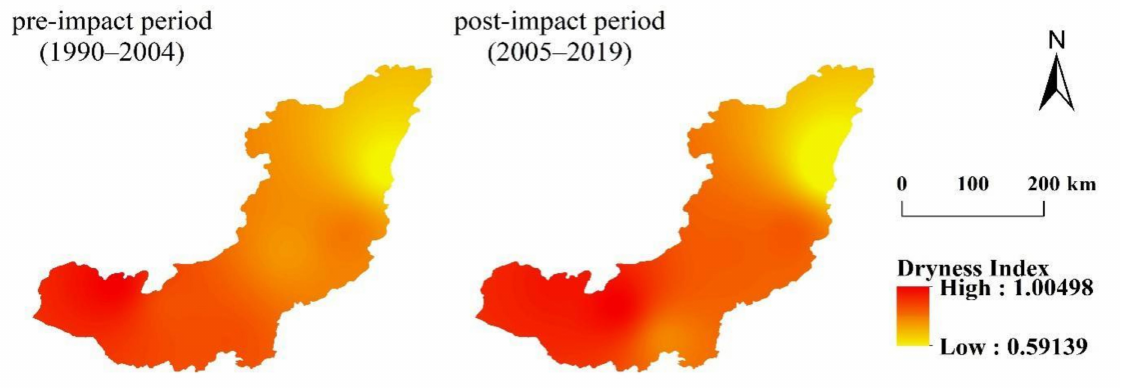
Figure 8. Spatial distribution of dryness index in Wujiang River Basin in the difference